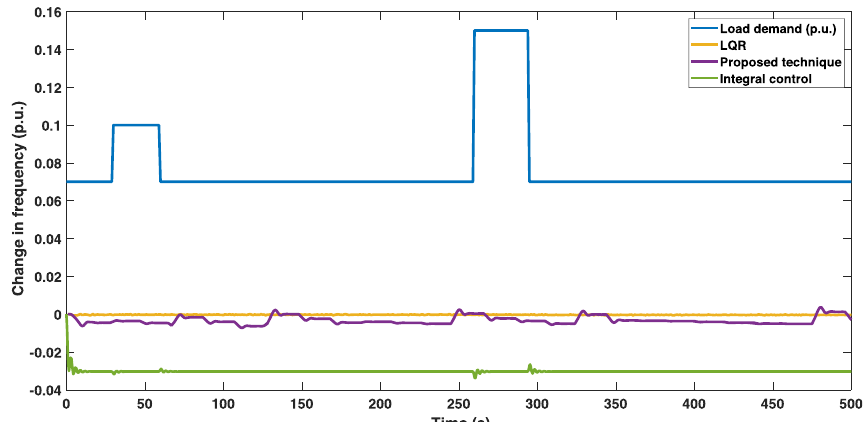
Fig. 10 Comparison of frequency deviation of the system considered with the application of integral control, LQR and proposed technique for a measurement noise variance of 0.01